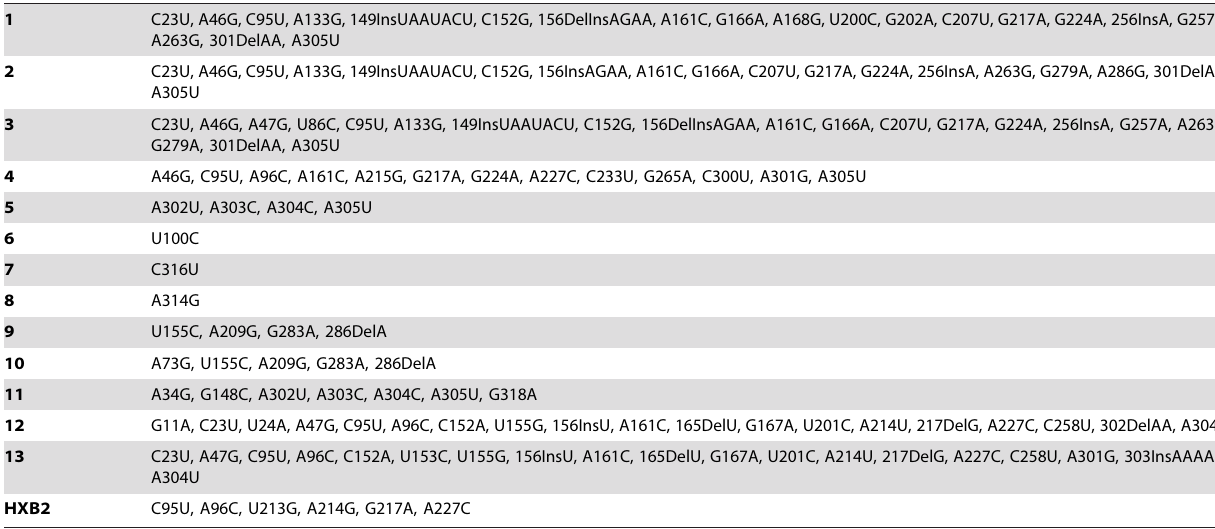
Variant (VAR) Nucleotide changes with respect to pNL4.3 (AF